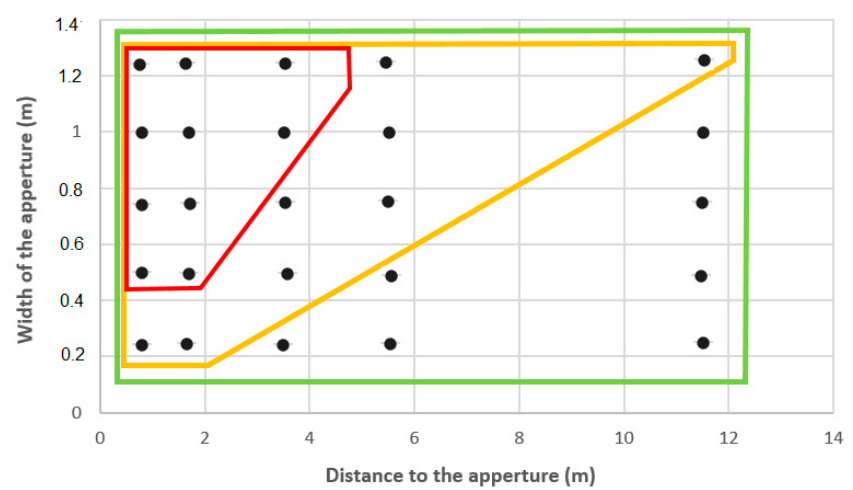
Figure 5. Detection performance for apertures, with black points representing points of measurement from different distances. The red parallelepiped contains points indicating apertures detected at 0.8 rad/s; those inside the yellow parallelepiped indicate apertures detected at 0.4 rad/s and the green parallelepiped indicates full aperture detection at 0.2 rad/s.